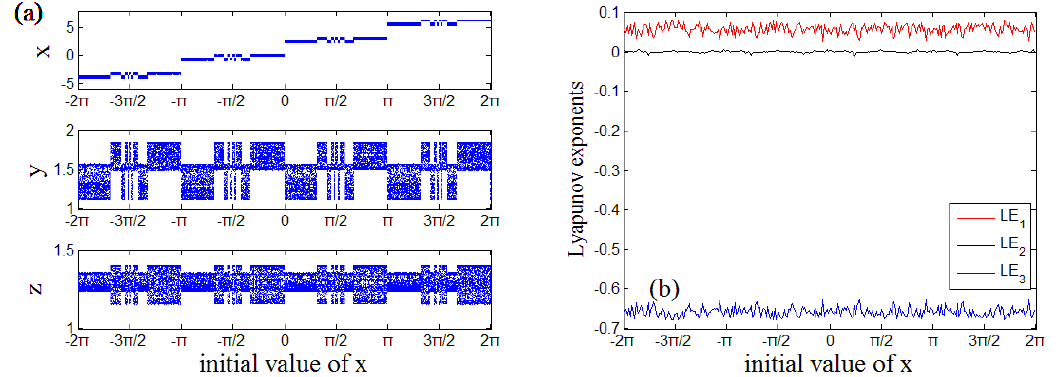
Figure 5. ( a ) Bifurcation diagram, ( b ) Lyapunov exponent spectra versus the initial value x 0 .